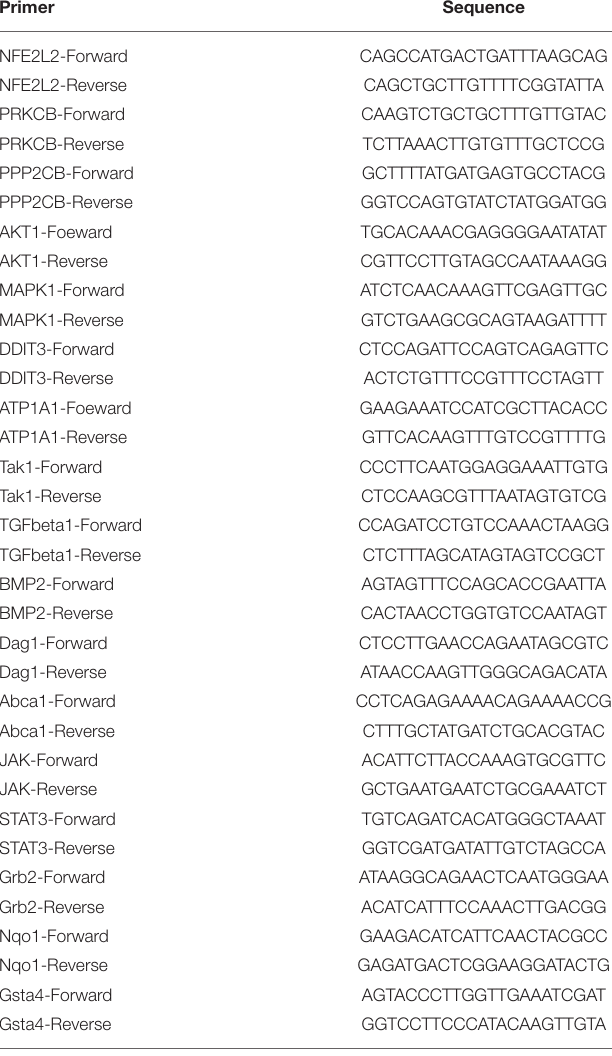
TABLE 3 | Primer sequences used in